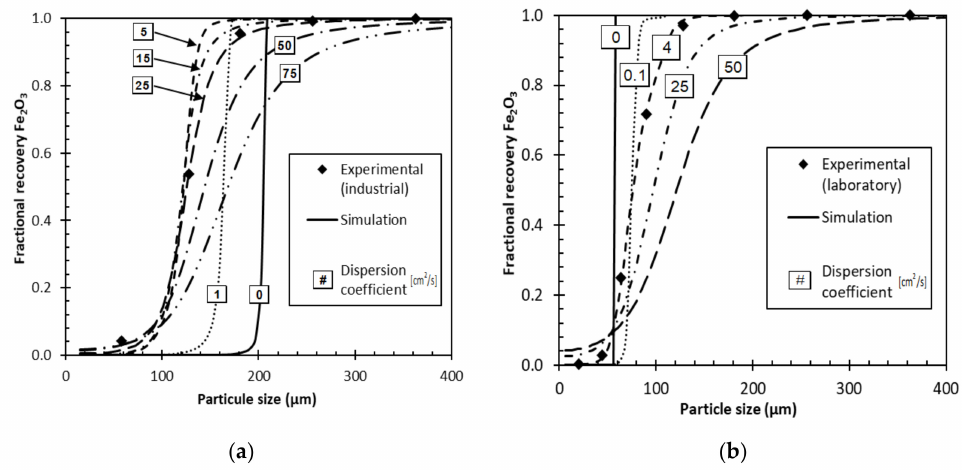
Figure 4. Influence of the axial dispersion coefficient on the fractional recovery of hematite (Fe 2 O 3 ) in the simulation of ( a ) an industrial experiment and ( b ) a laboratory experiment.